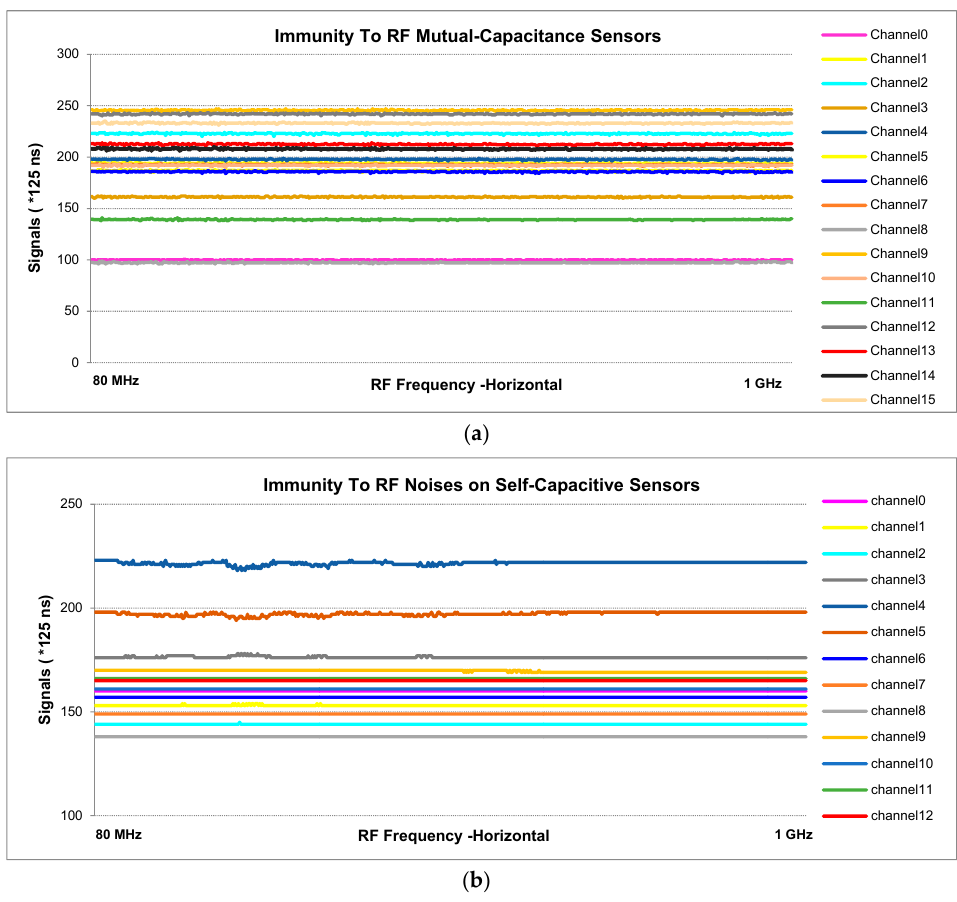
Figure 13. Radiated immunity test to radiated, radio-frequency and electromagnetic fields for: ( a ) mutual-capacitance; ( b ) self-capacitance.